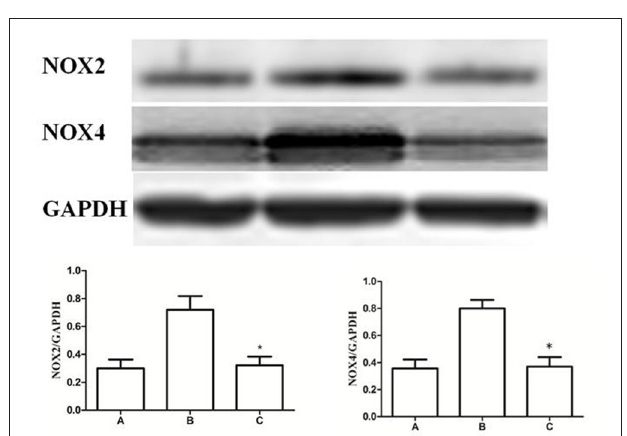
FIGURE 9 | Expression of IL-1beta in the gastric mucosa. (A) Western blots of IL-1 β in the gastric mucosa. (B) Quantitative analysis of IL-1 β in the gastric mucosa. GAPDH was used as a loading control. *** P < 0.001, as compared with the GI-R group; ### P < 0.001, as compared with the GI-R group; NN P < 0.01, as compared with the GI-R group. A, Normal group; B, GI-R group; C, FN + GI-R + L -Glu group; D, LHA + GI-R + Baclofen group; E, LHA + GI-R + CGP35348 group. n = 5.